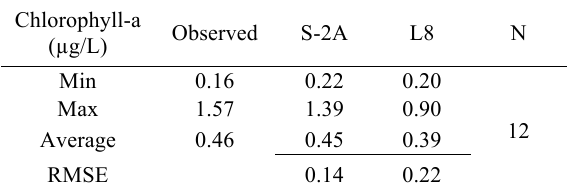
Table 2. Accuracy assessment of satellite-derived chlorophyll-a for the Wakasa Bay using in-situ data. (S-2A = Sentinel-2A; L-8 = Landsat-8, N= number of validation